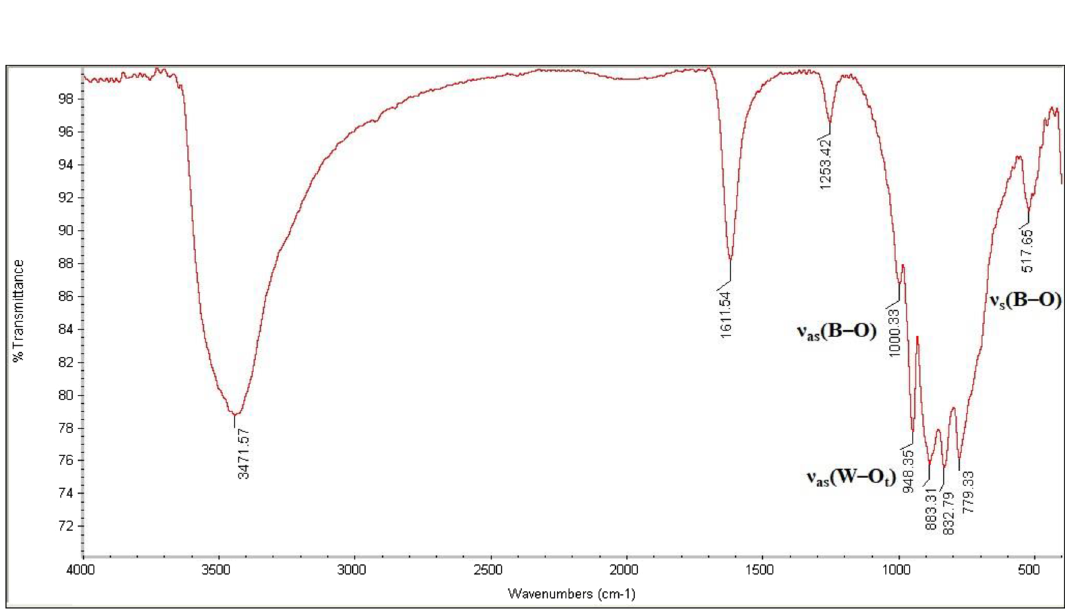
Figure 9. FTIR spectrum of nano- Gd-B 2 W 22